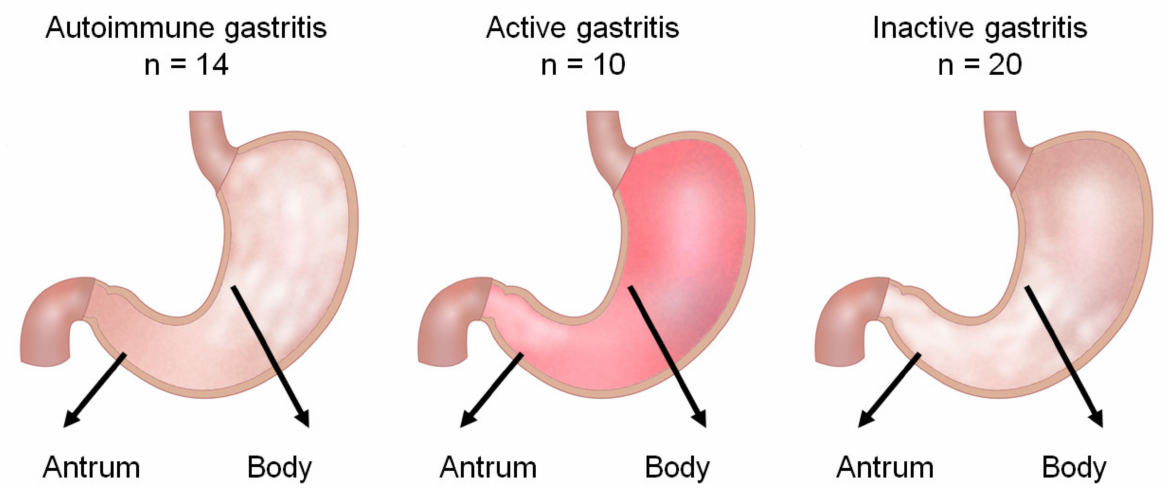
Figure 4. Schema of biopsy sample acquisition for flow cytometry. We endoscopically harvested one specimen from the greater curvature of the gastric antrum and the other specimen from the lesser curvature of the